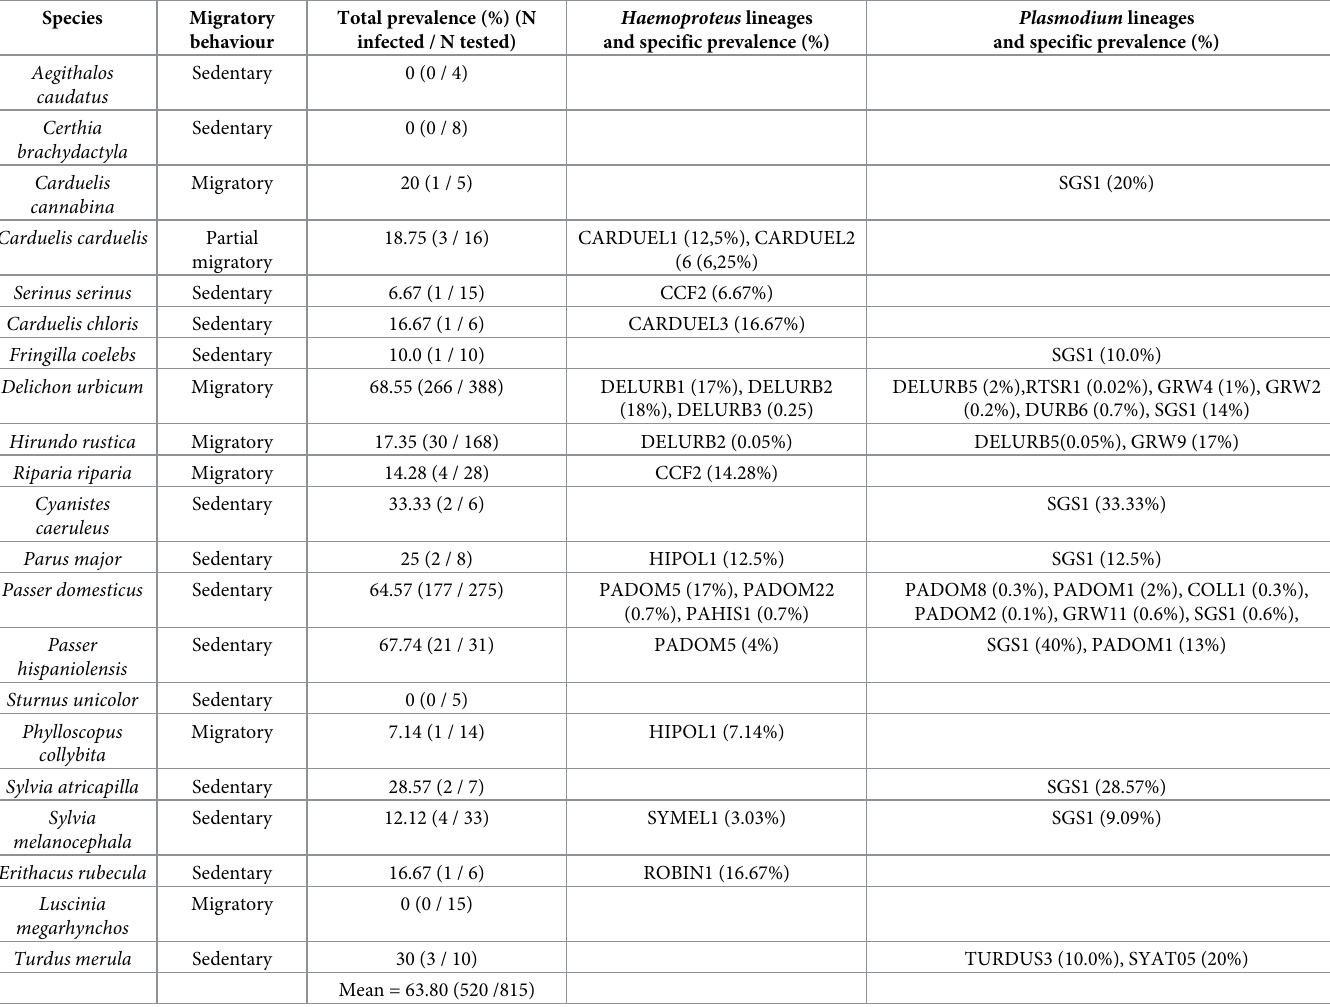
Table 1. Prevalence and genetic identity of haemosporidian parasite lineages in Passeriform host species analyzed in this study and parasite lineage found in each host species. Species Migratory